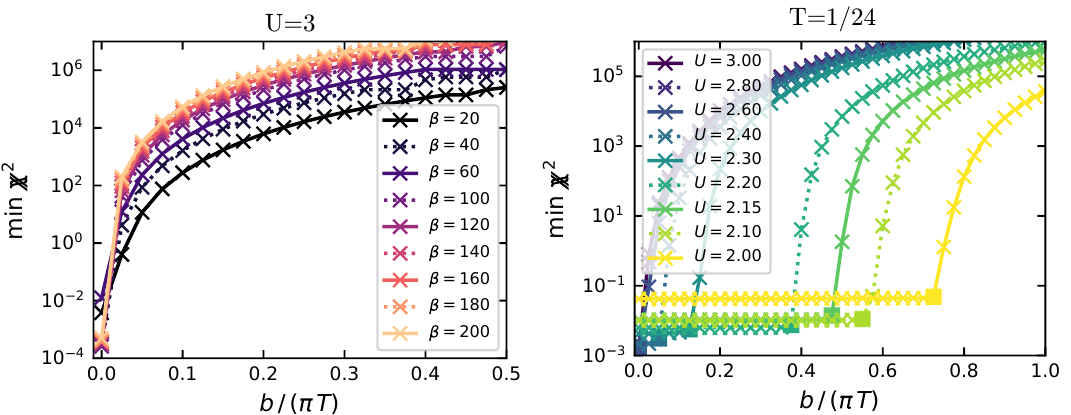
Figure 11: Left: various temperatures in the insulating phase with the onsite inter- action U = 3. Right: Minimum value of the fit loss for a range of interaction values at a temperature above the critical point T = 1 /